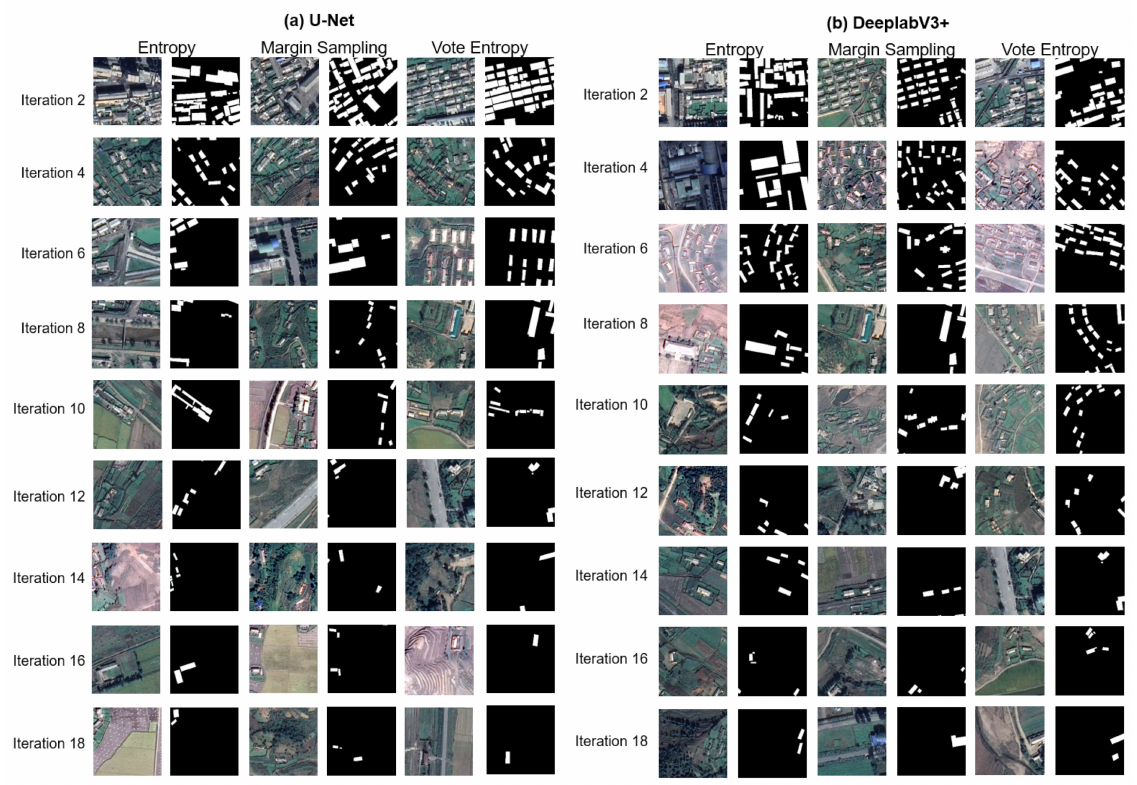
Figure 7. Example of image–label pairs selected by active learning strategies based on U-Net ( a ), DeeplabV3+ ( b ), and WHU satellite dataset